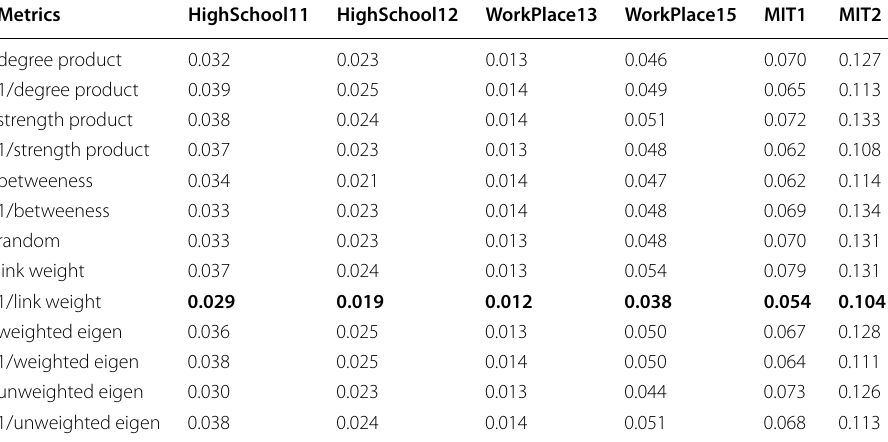
Table 8 The average prevalence E [ ρ ] when the recovery rate is γ = 1.22 ∗ 10 − 6 per step, and φ = 10% of the contacts are removed from each temporal network using removal probability (3) based on each centrality metric and f ( t ) = 4 · 1 t ≤ T / 2 + 1 t > T / 2 . Contacts occurring early in time i.e. t < T / 2 are